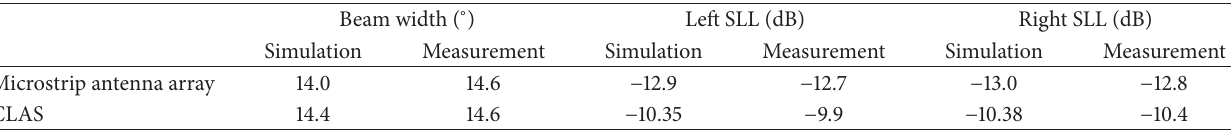
Table 2: The simulation and measurement results of some electrical parameters.